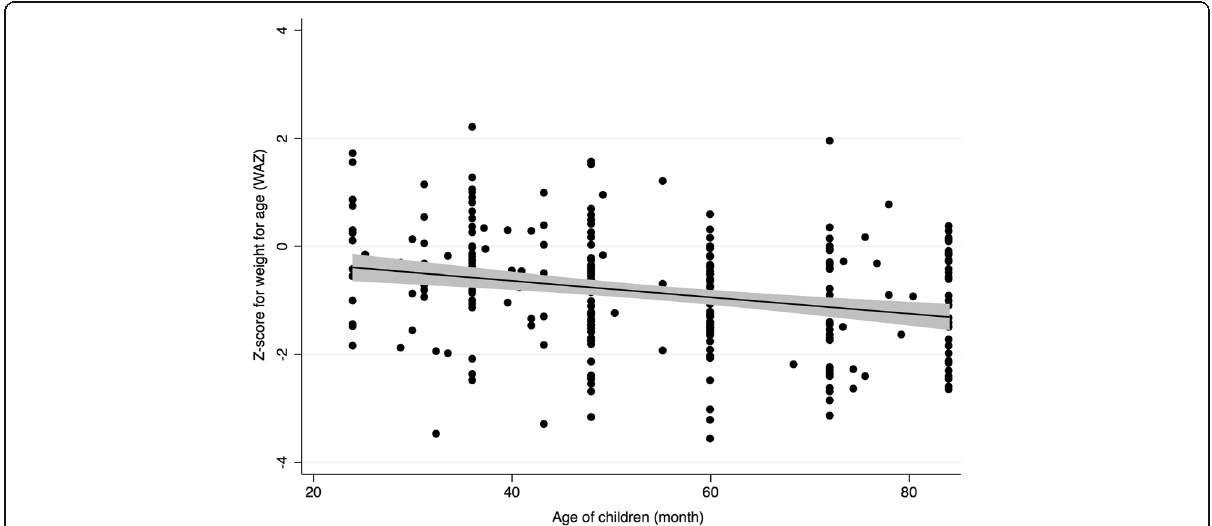
Fig. 3 Correlation of underweight (weight-for-age z -scores) with the age of the children in the follow-up survey. This scatter diagram shows the distribution of z -scores of weight-for-age (WAZ) that is the measure of underweight, with the fitting line and shaded 95% confidence interval, of the children who lived in temporary shelters after the 2015 Nepal earthquake in Bhaktapur, Nepal, in the follow-up survey after 2 years ( n = 285, P <